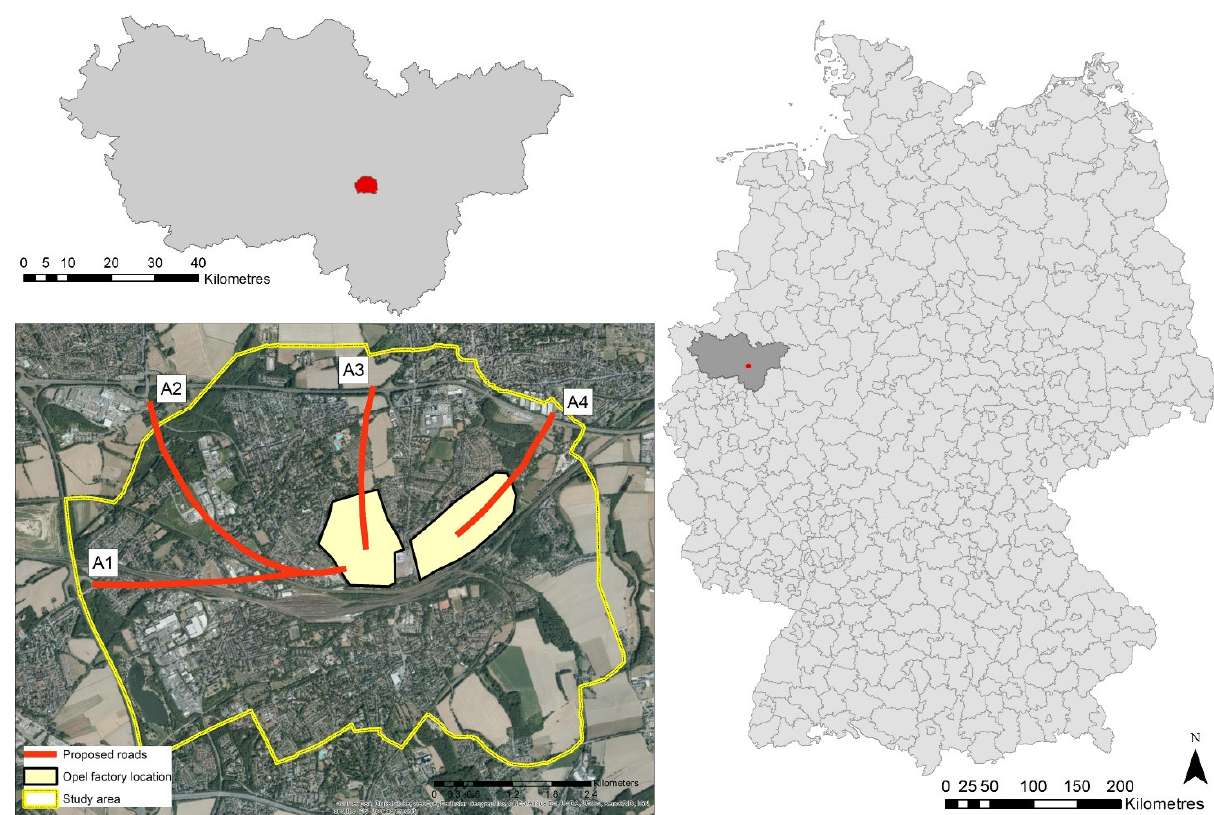
Figure 1. Location of the study area in Germany and the Ruhr area, and main features. Four alternative access roads to the GM/Opel European logistics centre are under discussion (A1, A2, A3 and A4). Satellite imagery: ESRI, DigitalGlobe, GeoEye, Earthstar Geographics, CNES/Airbus DS, USDA, USGS, AeroGRID, IGN, and the GIS User Community.